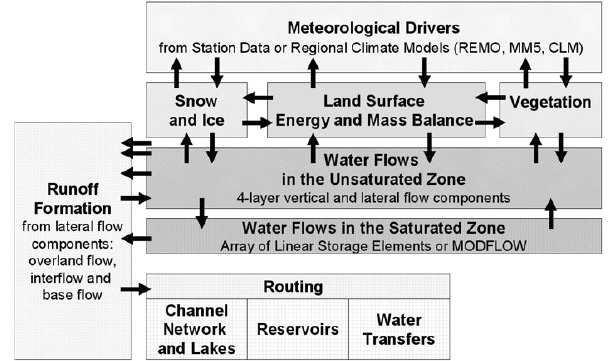
Figure 1. Schematic diagram of the components of PROMET, the DANUBIA landsurface core model, and the interfaces between them. Boxes indicate components and arrows indicate interfaces, through which data is exchanged (Mauser and Bach, 2009, p.